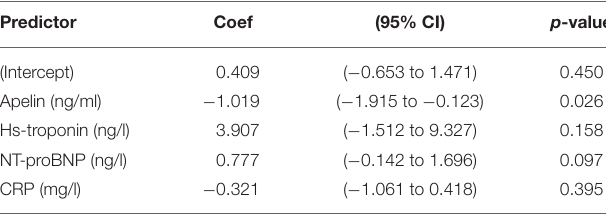
TABLE 3B | Logistic regression model for AF predictors based on selection from bivariate analysis (predictors with p <